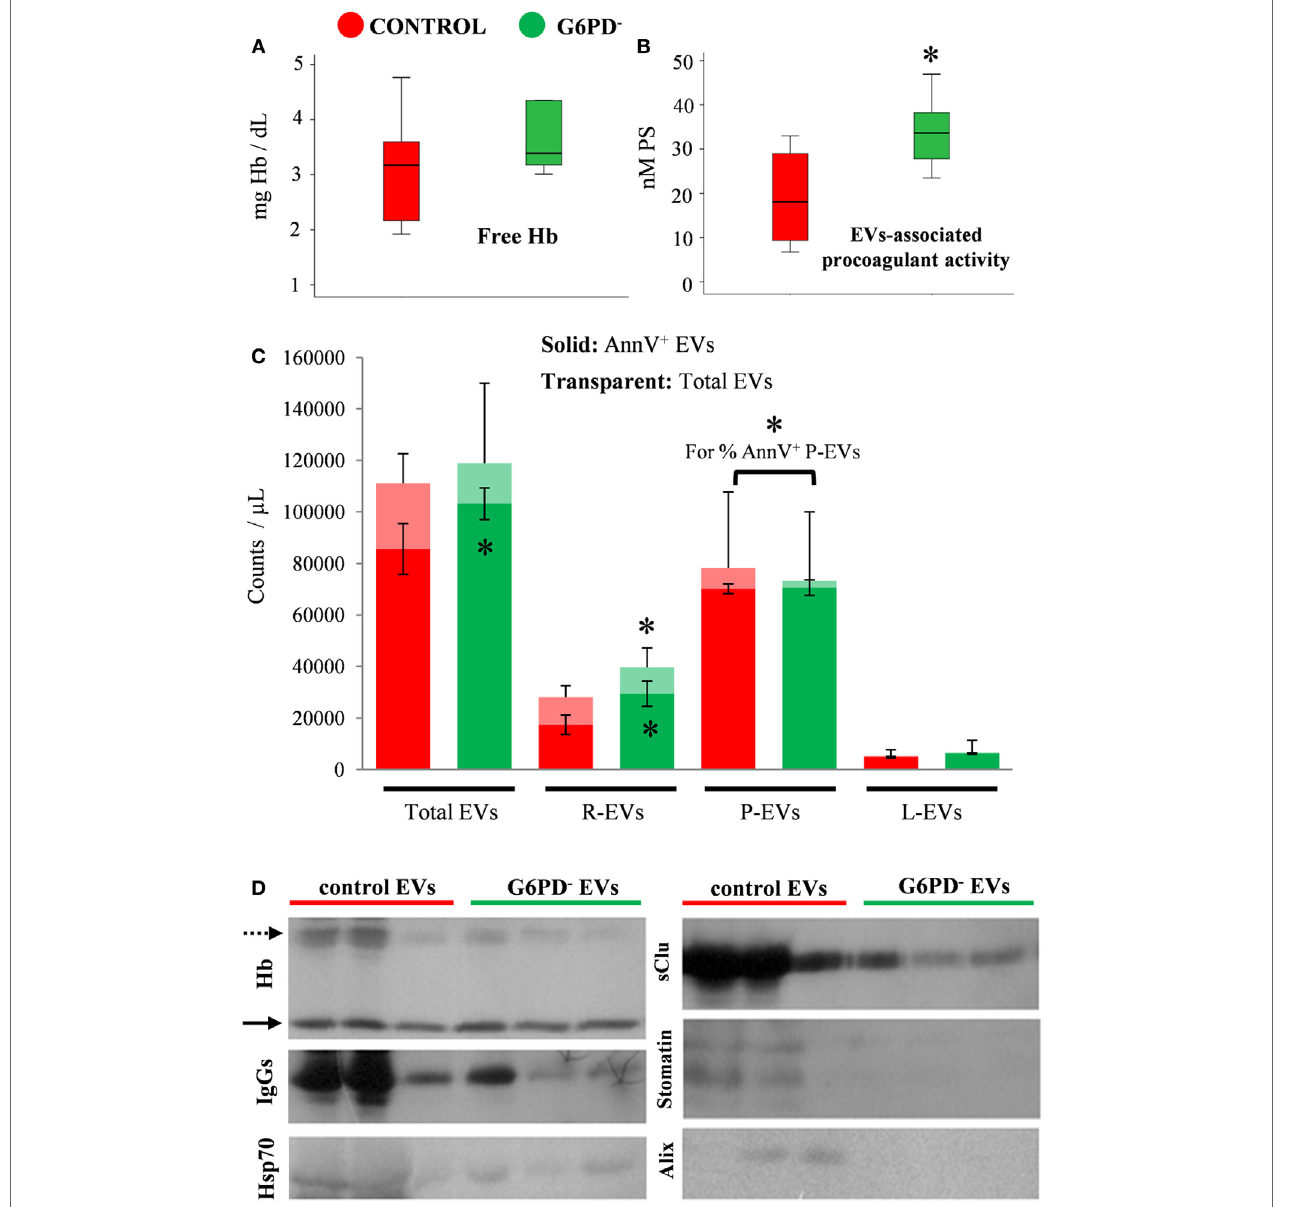
FigUre 2 | Hemolysis and extracellular vesicles (EV) analyses in fresh frozen plasma (FFP) units prepared from G6PD-deficient (G6PD − ) and control donors. Free hemoglobin (Hb). (a) and EV-associated procoagulant activity (B) levels in the G6PD − and control FFP units. (c) Enumeration and phenotyping of total and annexin V positive (AnnV + ) EVs by flow cytometry. R-, P-, L-EVs stand for red cell-, platelet-, and leukocyte-derived EVs, respectively. * p < 0.05, G6PD − vs. control FFPs; error bars: mean ± SD. (D) Representative immunoblots showing similar Hb levels (solid arrows) but variable expression of other protein components in EVs precipitated by high-speed centrifugation of equal volumes of G6PD − and control FFP. Dashed arrow: oxidized Hb